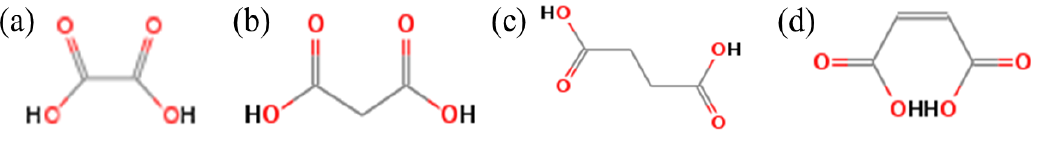
Figure 9. Molecular structural formula of ( a ) OA, ( b ) PD, ( c ) SA and ( d ) MA.